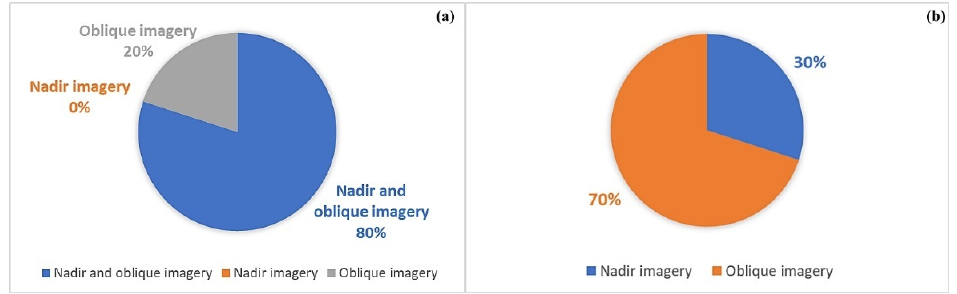
Figure 8. ( a ) Overall assessment of the accuracy of the photogrammetric products in accordance with UAV acquisition geometry using length comparison; ( b ) assessment of the accuracy of the photogrammetric products using length comparison between nadir- and oblique-viewing geometry.